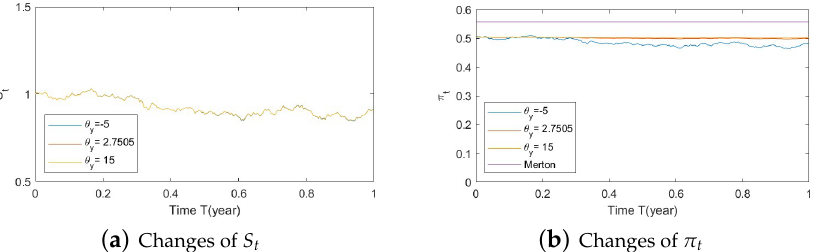
Figure A35. Illustrate the impact on ( a ) stock prices and ( b ) optimal stock allocations when varying θ y ( e . g ., θ y = − 5,2.7505,15 ) .